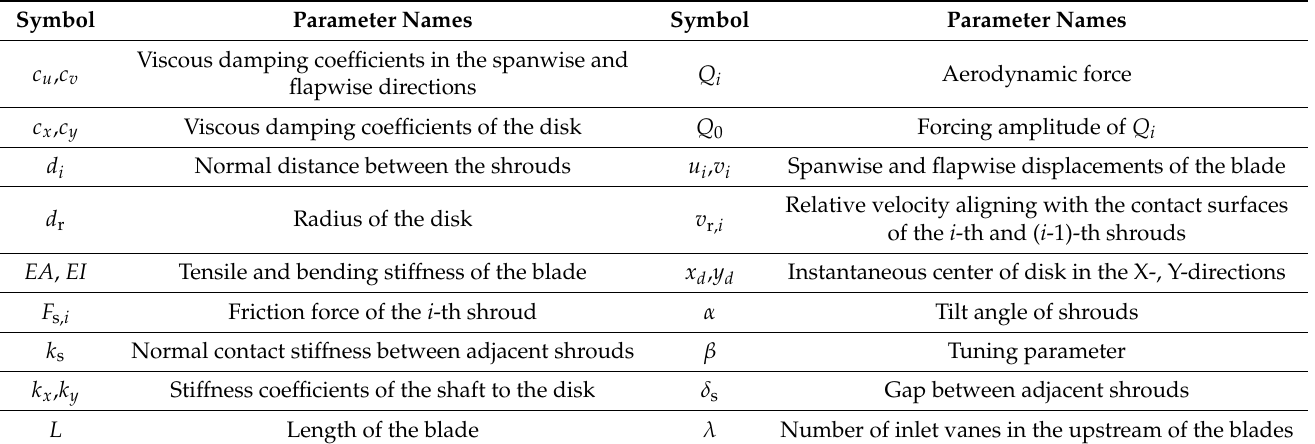
Table A1. Nomenclature of the most important